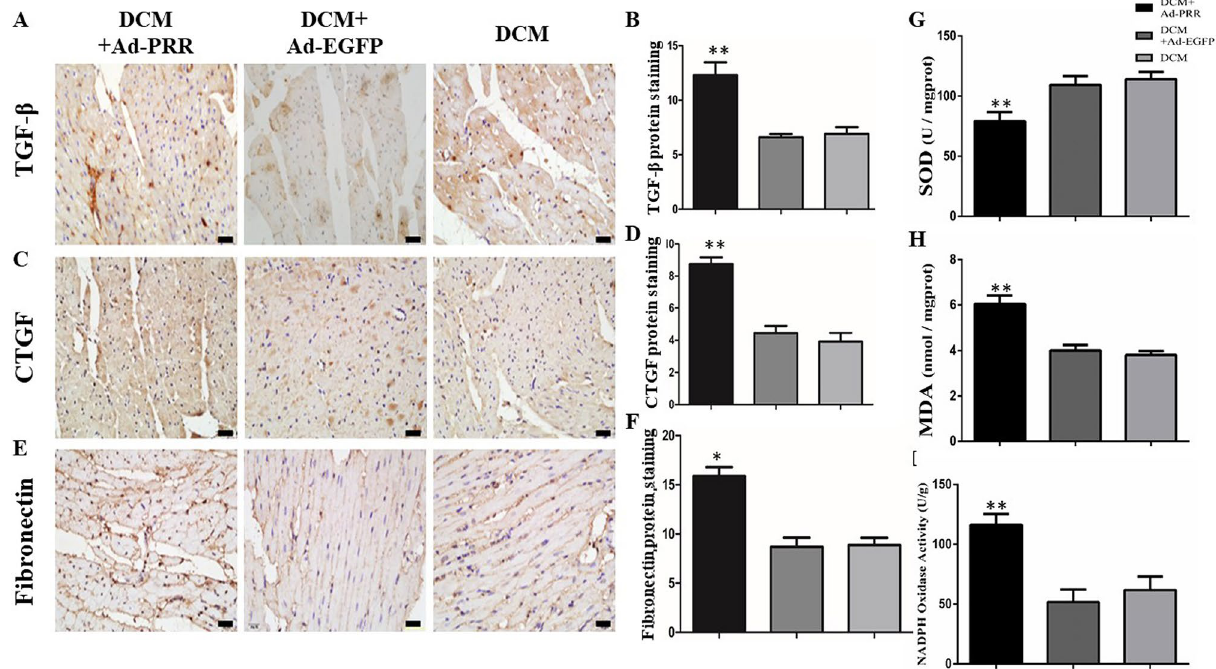
Figure 2. TGF-β, CTGF and fibronectin expression in the 3 groups and SOD and, MDA levels and NADPH oxidase activity in the 3 groups. ( A ) Immunostaining of TGF-β, ( B ) Quantitative analysis of the results shown in ( A ). ( C ) Immunostaining of CTGF, ( D ) Quantitative analysis of the results shown in ( C ). ( E ) Immunostaining of fibronectin. ( F ) Quantitative analysis of the results shown in ( E ). ( G ) SOD levels in the 3 groups. ( H ) MDA levels in the 3 groups. ( I ) NADPH oxidase activity in the DCM group, Ad-EGFP group, and Ad-PRR group. * p < 0.05, ** p < 0.01 compared with the DCM group and Ad-EGFP group. Scale bar = 20 μm, magnification × 40. In 4 weeks after removing dead rats, the other of rats incorporate into analysis, in DCM group had 11 rats, Ad-PRR group had 11 rats and Ad-EGFP group had 12 rats